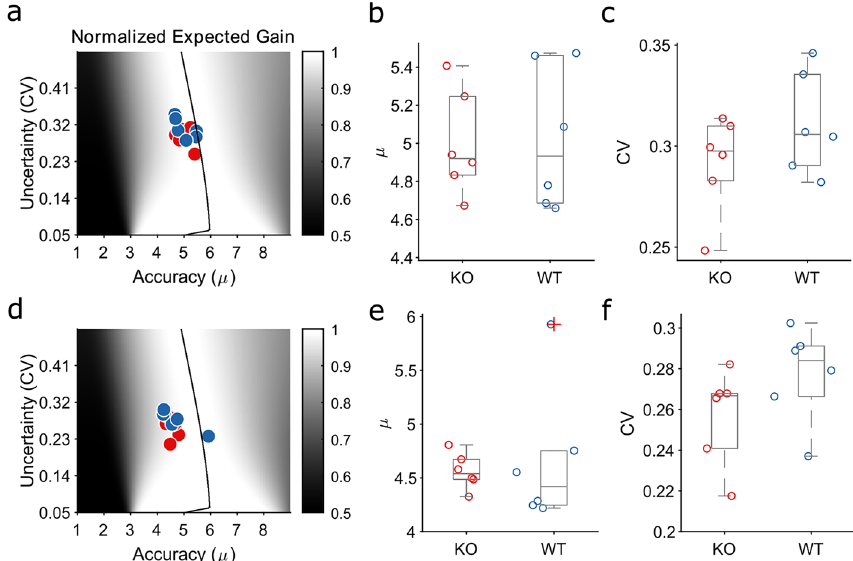
Figure 5. Preserved temporal decision-making in TAAR5 mice. ( a ). Normalized expected gain surface. Shades of grey identify the expected gain given every combination of accuracy (μ) and uncertainty (CV). The solid black line identifies the maximum expected gain for each combination of accuracy and uncertainty. Blue (WT) and red (KO) dots show the distribution of expected gain for each subject during the first week of training. ( b ). Boxplot distribution of accuracy (μ) during the first week of training. Each circle is a subject. Kolmogorov– Smirnov test p = 0.8 ( c ). Boxplot distribution of uncertainty (CV) during the first week of training. Each circle is a subject. Kolmogorov–Smirnov test p = 0.8 ( d ). Similar to panel a for the second week of training. ( e–f ). Similar to panels b-c, respectively, for the second week of training. Kolmogorov–Smirnov test, p = 0.3 and p = 0.3, respectively for panel ( e ) and ( f